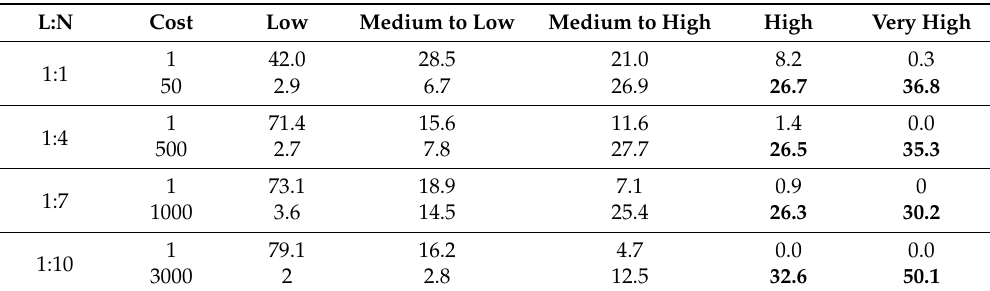
Figure 6. Comparison of the representative results ( Y axis: accuracies) of 2008 dataset prediction obtained using RF, DT, BN, and logistic algorithm with cost-sensitive analysis, where RF, DT, BN,OA, UA, PA, AUC, L, and N indicate random forests, decision tree, and Bayes network algorithm, overall accuracy, user’s accuracy, producer’s accuracy, area under ROC curve, landslide class, and non-landslide class, respectively. ( a ) L:N = 1:1; ( b ) L:N = 1:4; ( c ) L:N = 1:7; ( d ) L:N = 1:10. Table 3. Landslide susceptibility distributions (Unit: %) of the 2008 occurrence samples based on the random forest algorithm with cost-sensitive